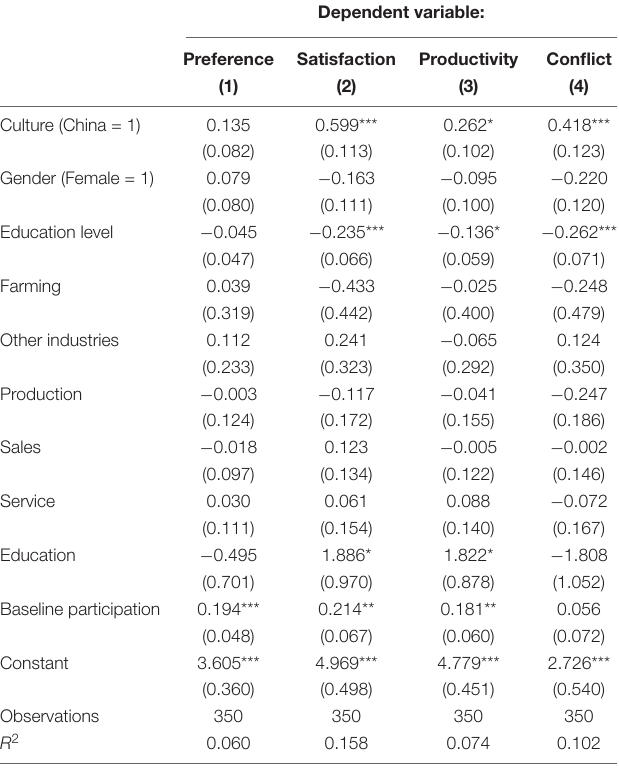
TABLE 4 | Study 2 results from linear